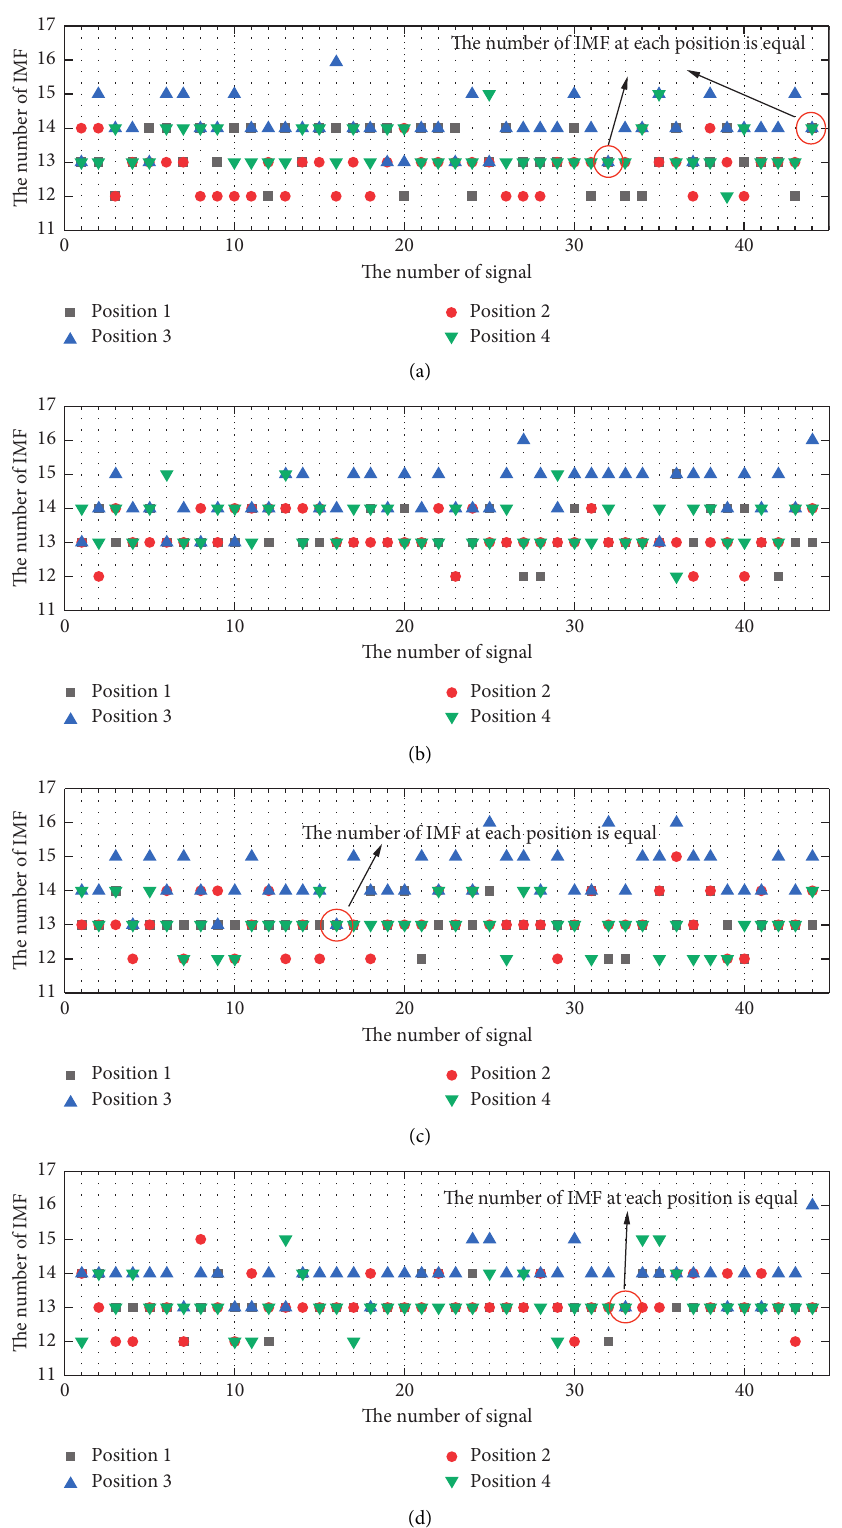
Figure 9: The distribution of IMF’s number decomposed by EMD. (a) Normal state. (b) Single cylinder misfire. (c) Neighbor cylinder misfire. (d) Far cylinder